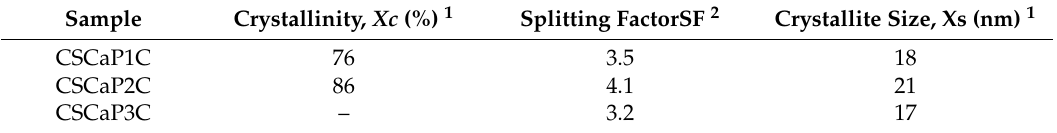
Table 2. Effect of CaP content on the crystallinity and crystallite size of CaP in the CSCaPC monoliths. Sample Crystallinity, Xc (%) 1